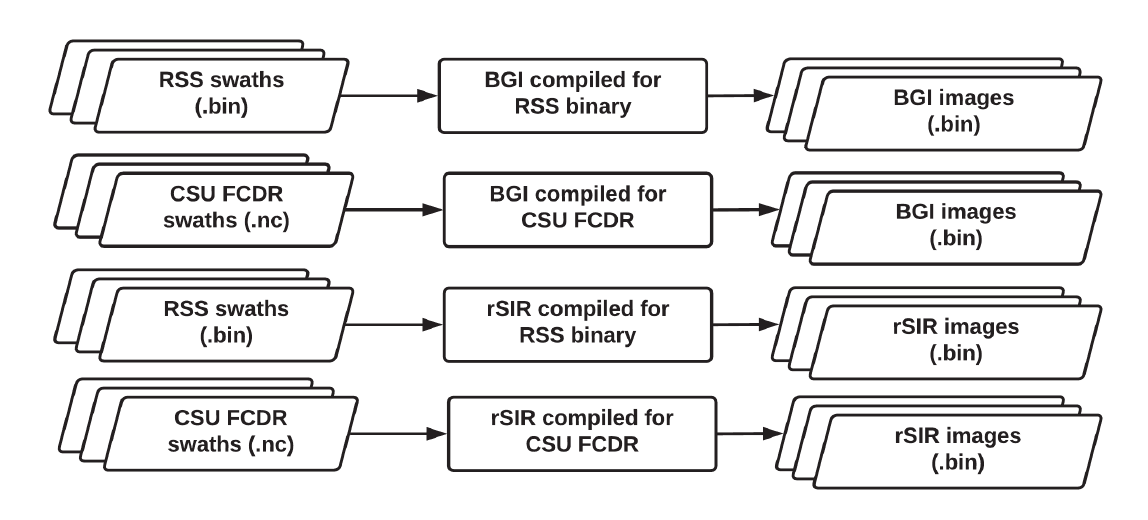
Figure 2. General design of original system, with duplication due to conditional compilation that would quickly become unwieldy with modifications for additional required input sensors and formats.